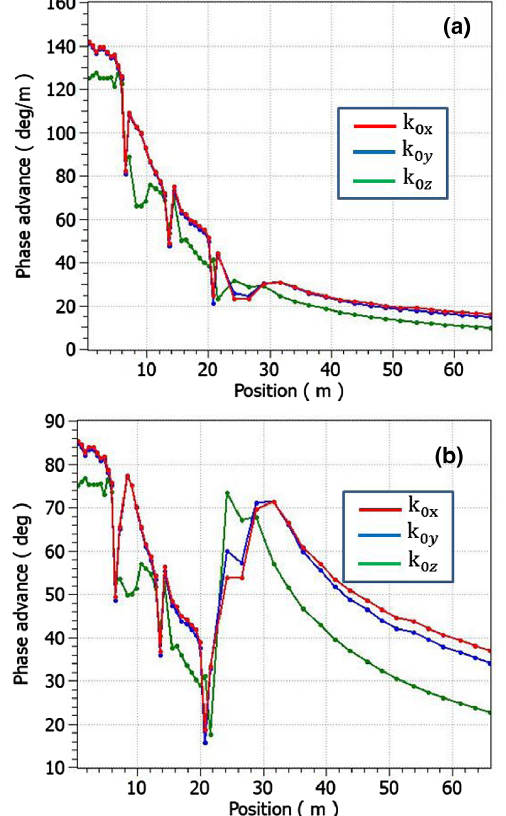
FIG. 36. (a) Variation of zero-current phase advance per unit length along the SC section of the MEHIPA linac, and (b) varia- tion of the zero-current phase advance per period along the SC section of the MEHIPA linac.